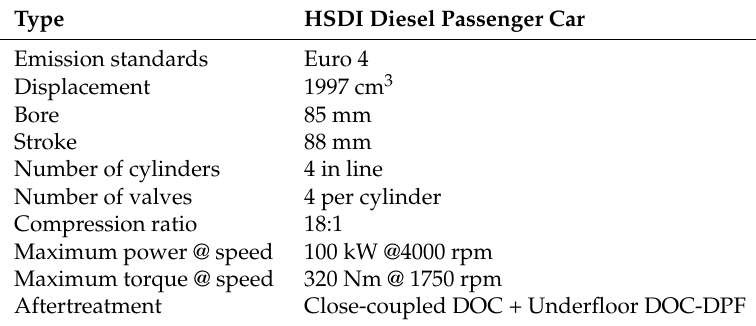
Table 2. Basic engine